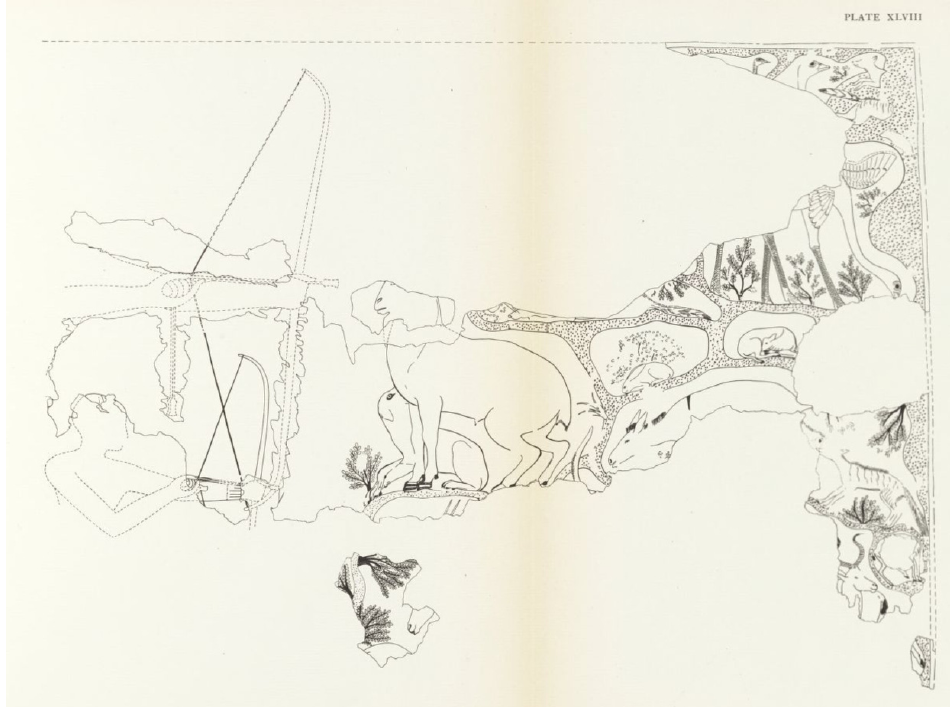
Figure 8. Hunting in the Desert, Tomb of Kenamun (TT89), Sheikh Abd al-Qurna, Thebes. 18th Dynasty. (Davies 1930, Pl. 7.).